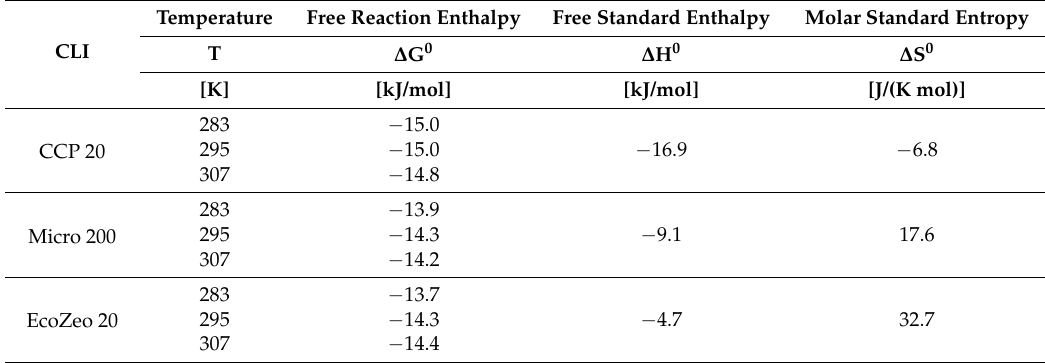
Table 7. Thermodynamic properties of CCP 20, Micro 200, and EcoZeo 20 after 20 h contact time